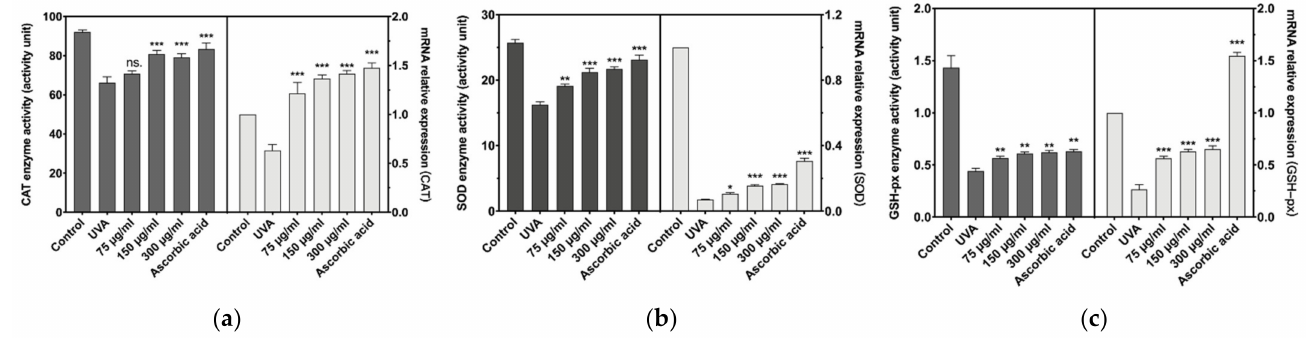
Figure 4. Changes of major intracellular antioxidant enzymes. ( a ) The enzyme activity and tran- scription level of catalase (CAT). ( b ) The enzyme activity and transcription level of Superoxide dismutase (SOD). ( c ) The enzyme activity and transcription level of glutathione peroxidase (GSH-px). Difference analysis between sample group and UVA model group: ns.: p > 0.05, *: p < 0.05, **: p < 0.01, ***: p <